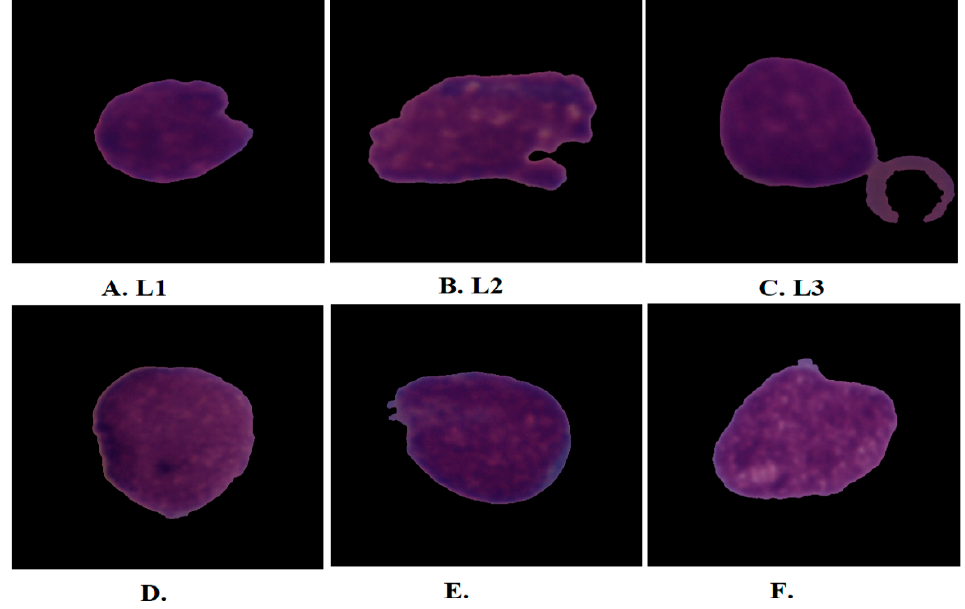
Figure 1. Samples from the C-NMC 2019 dataset. ( A – C ) acute lymphoblastic leukemia while ( D – F ) healthy images.